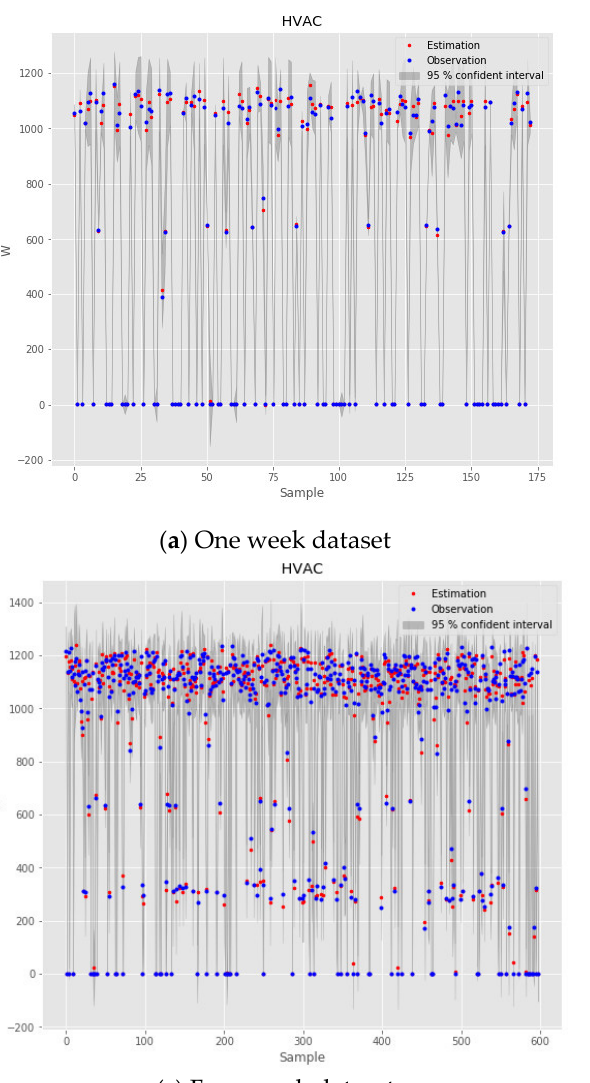
Table 3. Performance indices of the compensation of HVAC data.